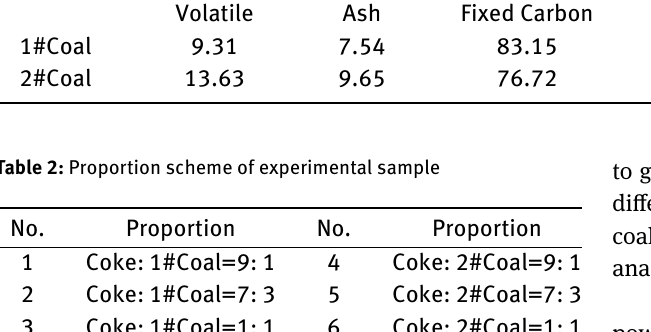
Table 1: Ultimate analysis and ultimate analysis of anthracite Proximate analysis, ad/%(mass)